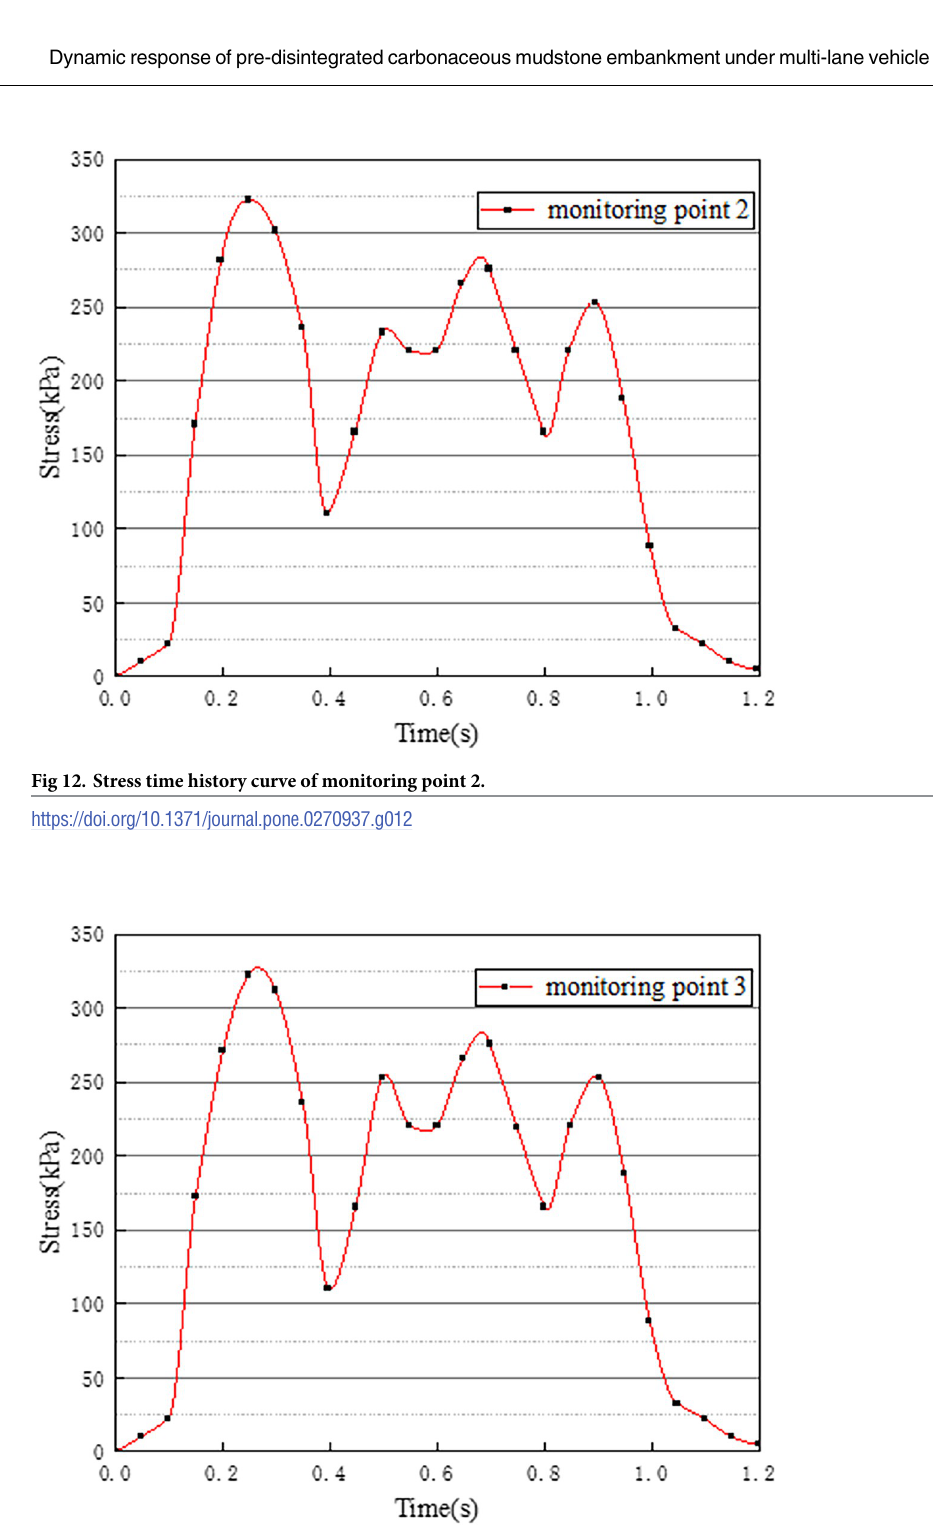
Fig 13. Stress time history curve of monitoring point 3.